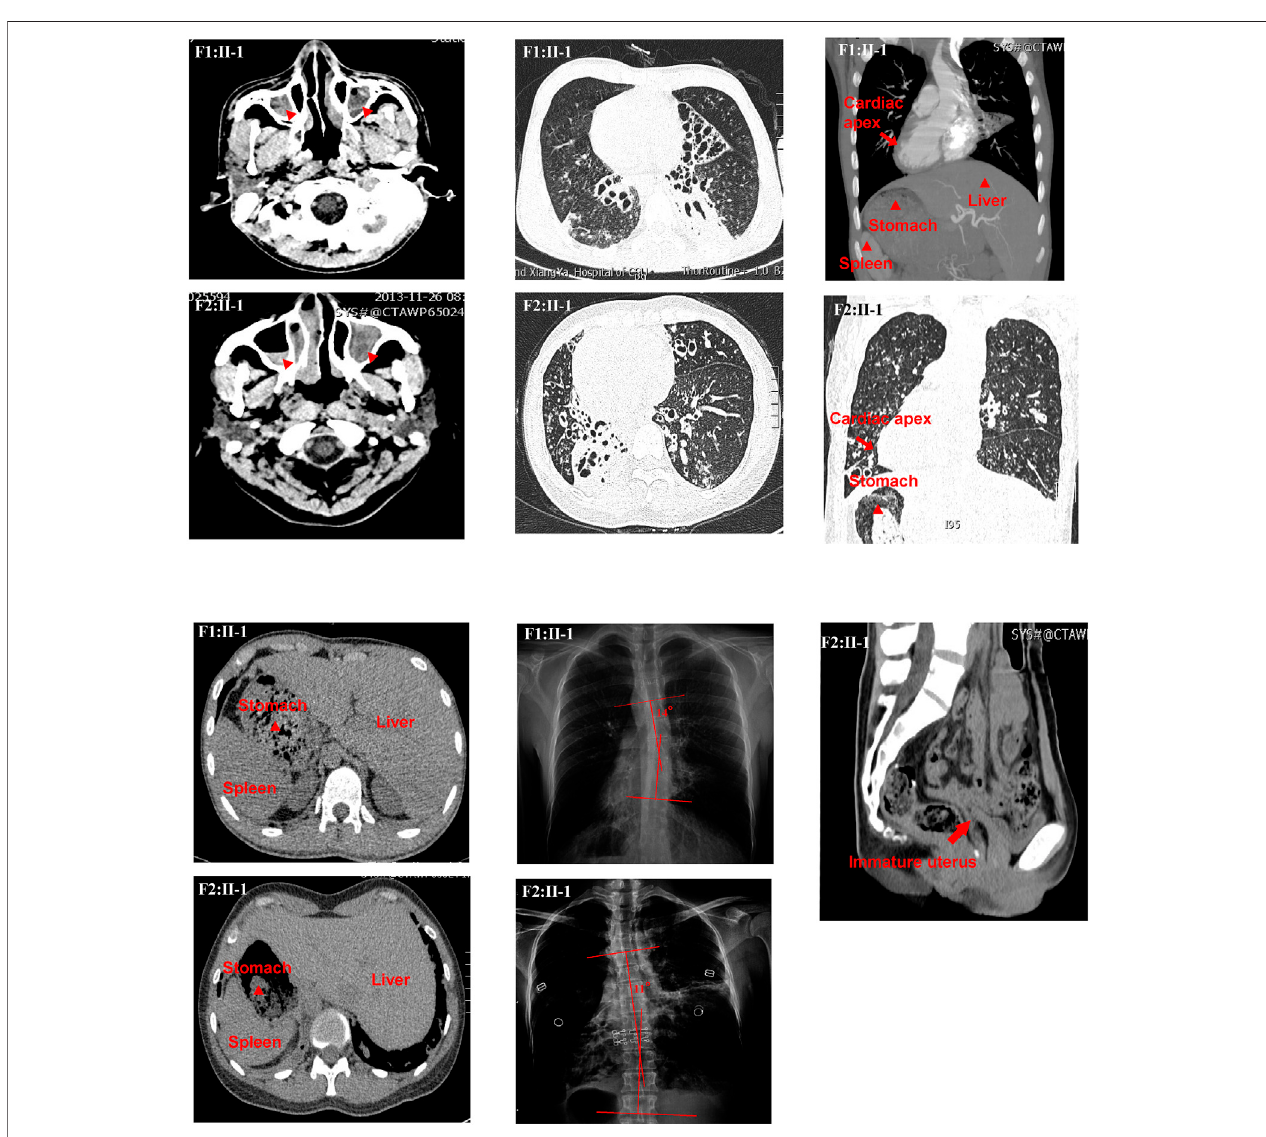
FIGURE 1 | Clinical features of the two patients. The chest high-resolution computed tomography (HRCT) scan of P1 (F1: Ⅱ -1) showed bronchiectasis, rhinosinusitis,andsitusinversus.RadiographicimageofP1(F1: Ⅱ -1)showedscoliosiswithaCobb ’ sangleof14 ° .TheHRCTscanofP2(F2: Ⅱ -1)showedbronchiectasis, rhinosinusitis, situs inversus, and immature uterus. Radiographic image of P2 (F2: Ⅱ -1) showed scoliosis with a Cobb ’ s angle of 11 ° .